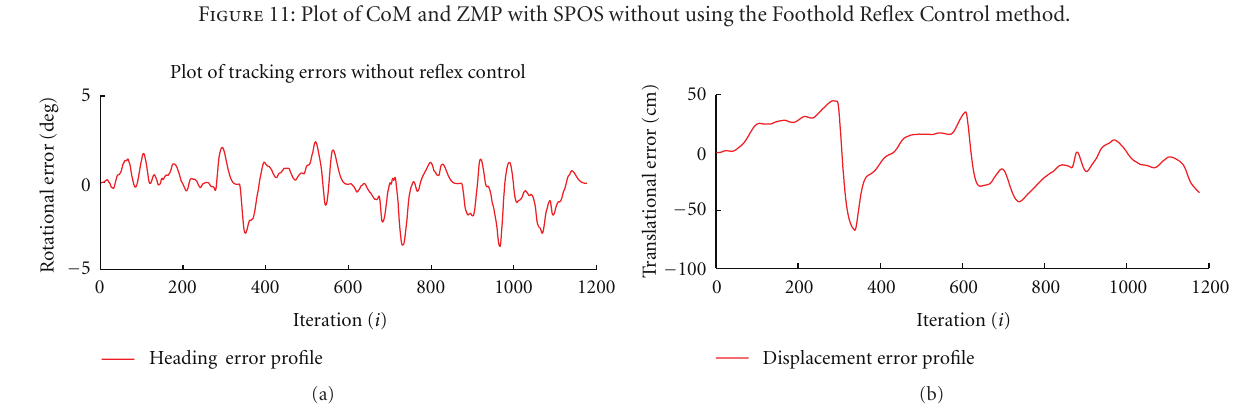
Figure 12: Tracking errors of robot locomotion without using the FRC method.